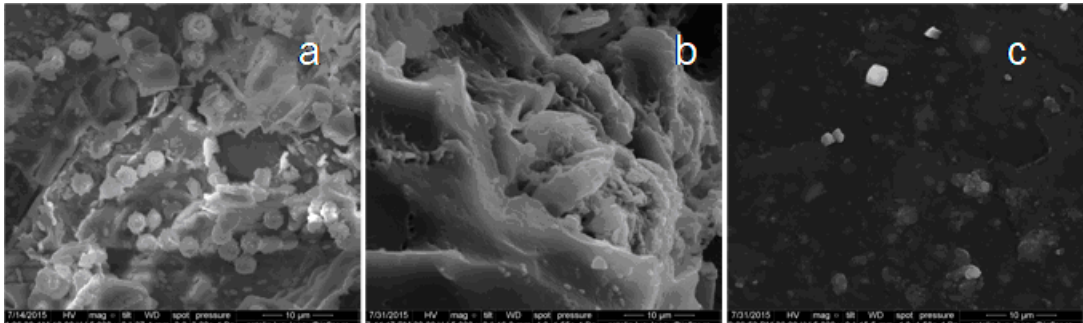
Figure 19. SEM of the B-2 composite. ( a ) after 60 days of incubation with Aspergillus niger ; ( b ) after 60 days of incubation with Aspergillus niger and after 72 h immersed in toluene; ( c ) the blanks (before incubation with the Aspergillus niger ) and after 72 h immersed in toluene.